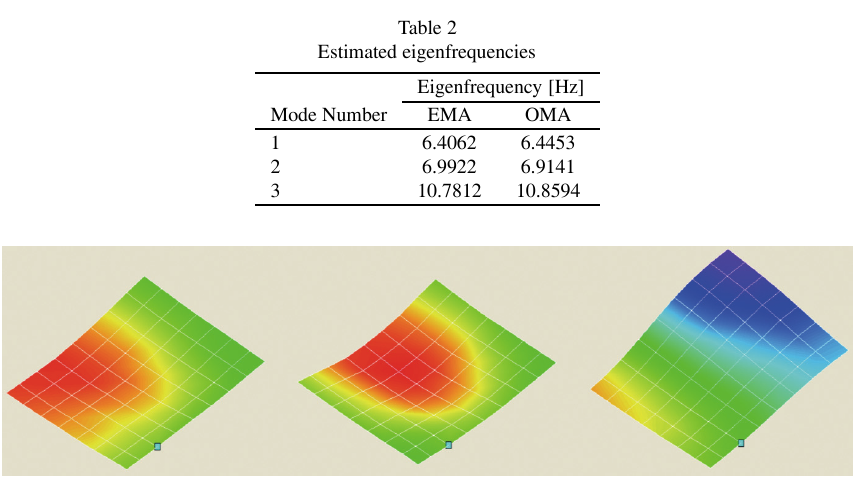
Fig. 8. Mode shapes of the fi rst three eigenfrequencies of the ceiling determined with EMA.